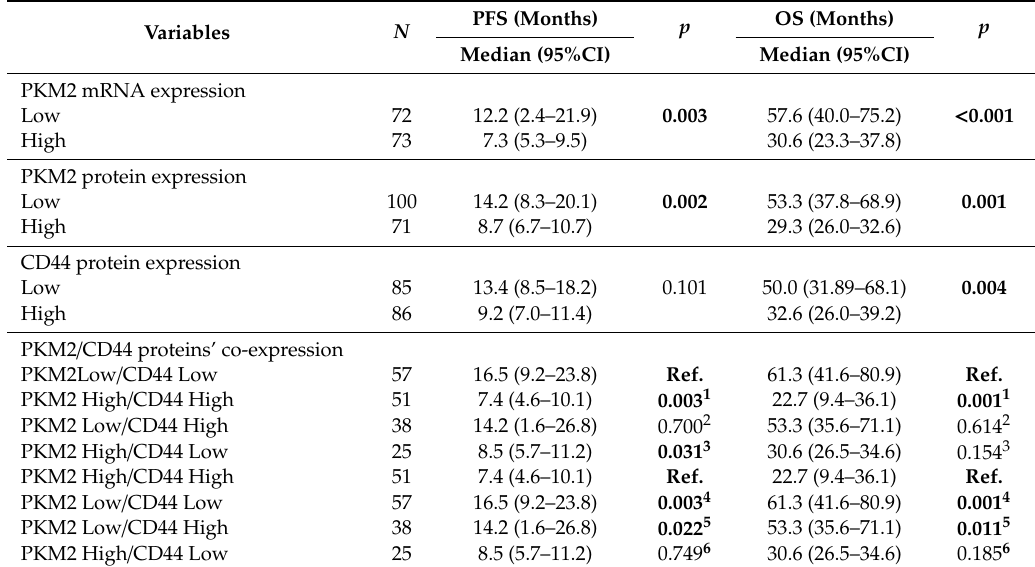
Table 2. Tumoral expression of PKM2 and CD44 and patients’